Question: What direction does the quantity move in — increasing or decreasing?
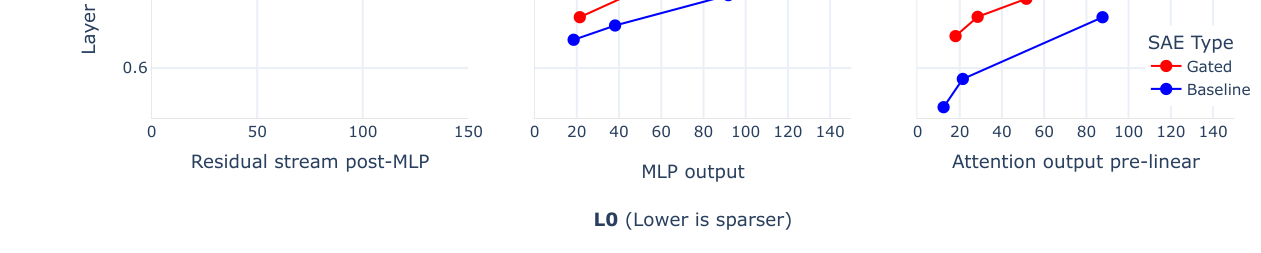
Answer: increasing